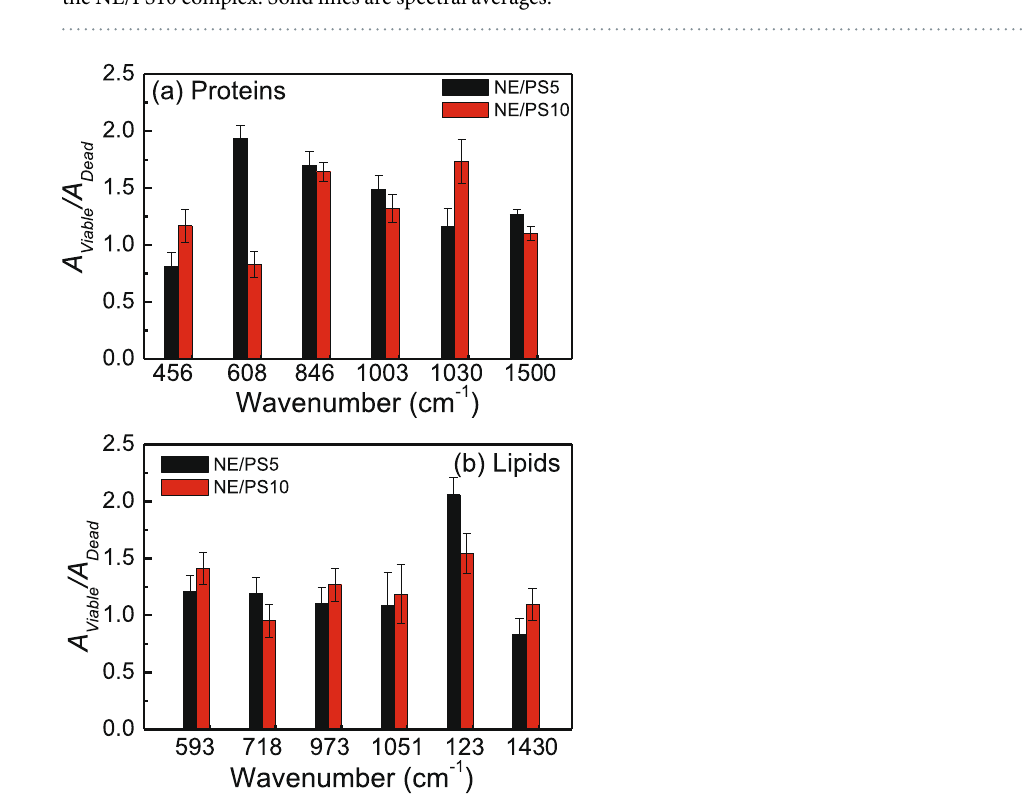
Figure 5. Raman peak area ratio (viable/dead cells) related to ( a ) proteins and ( b ) lipids. Data were collected for cells treated using both complexes (NE/PS5 and